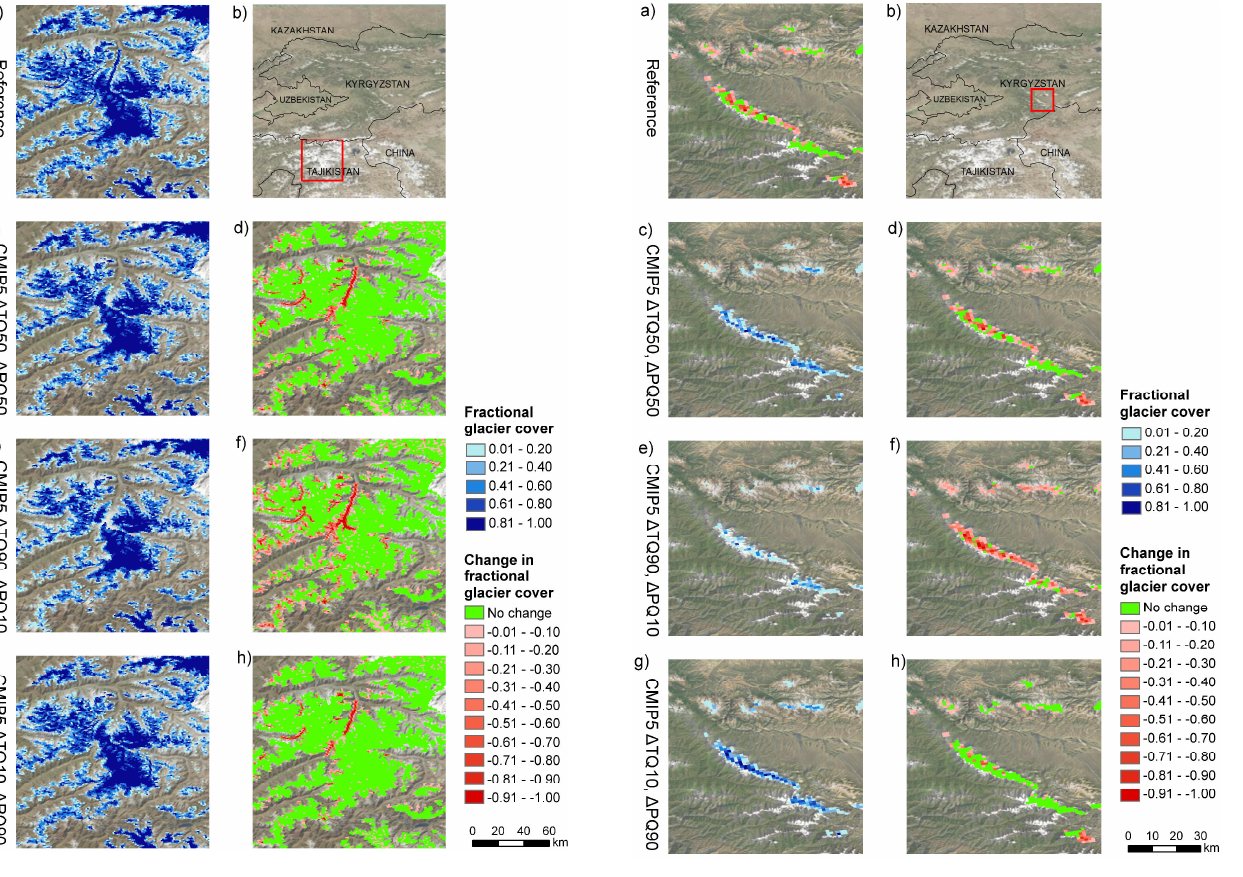
Fig. 15. Projected fractional glacier cover in 2050 for a slected area in the Tien Shan mountains. The square in the top right panel (b) represents the area enlarged in the other panels. Panel (a) shows the initial fractional glacier cover per 1km grid cell. The three lower left panels show the simulated fractional glacier cover per 1km grid cell in 2050 for the CMIP5 runs. Panel (c) shows the fractional glacier cover for the run with the 50th percentile (Q50) values of temperature and precipitation change. Panel (e) shows the projec- tion with the strongest decrease in glacier cover, when the model is forced with the 90th percentile (Q90) for temperature change and 10th percentile (Q10) for precipitation change. Panel (g) shows the projection with the least decrease in glacier cover, when the model is forced with the 10th percentile (Q10) for temperature and 90th percentile (Q90) for precipitation change. The three lower right pan- els (d, f, h) show the change in fractional glacier cover per grid cell for the 2050 projections in the three lower left panels (c, e, g) with respect to the initial glacier cover (a)